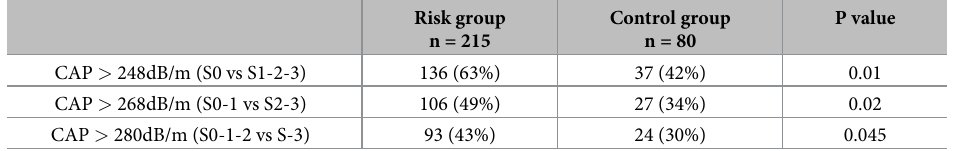
Table 2. Prevalence of steatosis in patients with (risk group) and without risk factors for NAFLD (control groups).